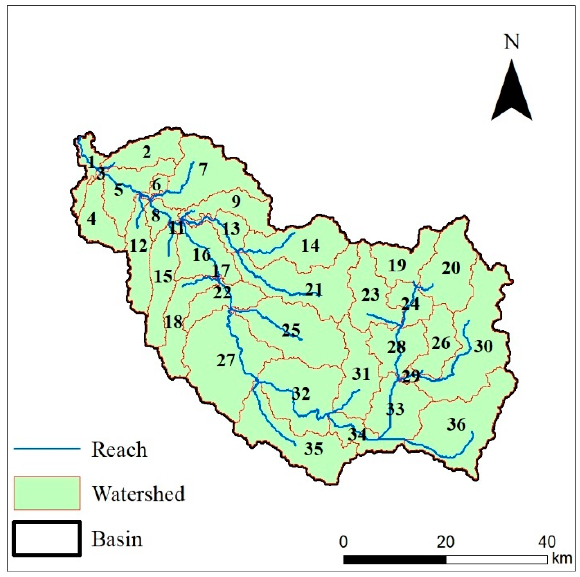
Figure 2. Map of watershed.